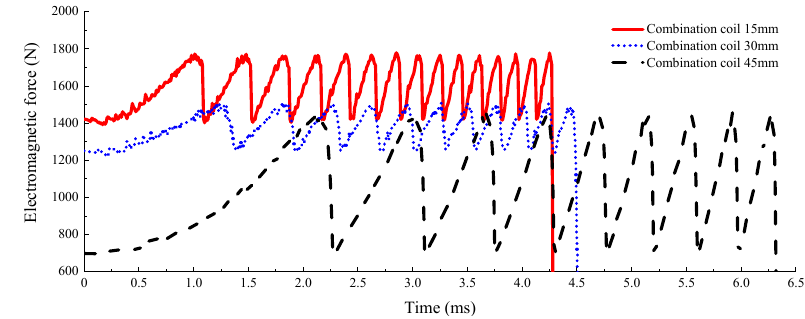
Figure 14. Comparison of steady state electromagnetic forces of combined coils with different lengths.